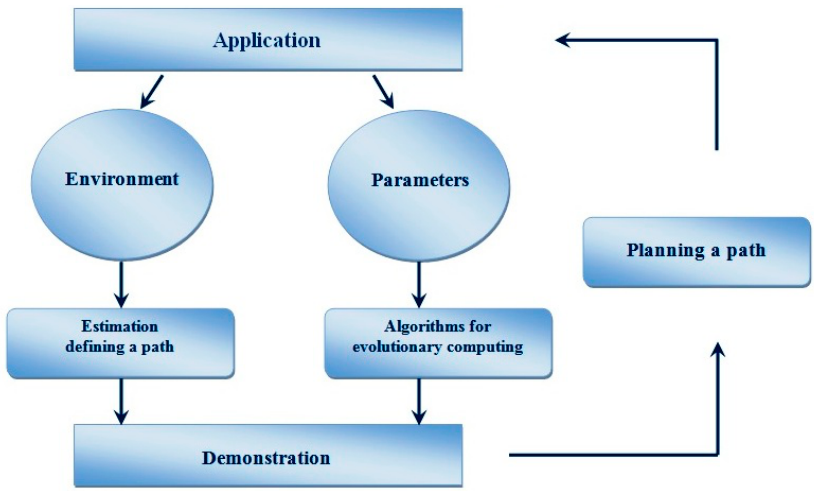
Figure 1. General planning system based on evolutionary calculation algorithms.